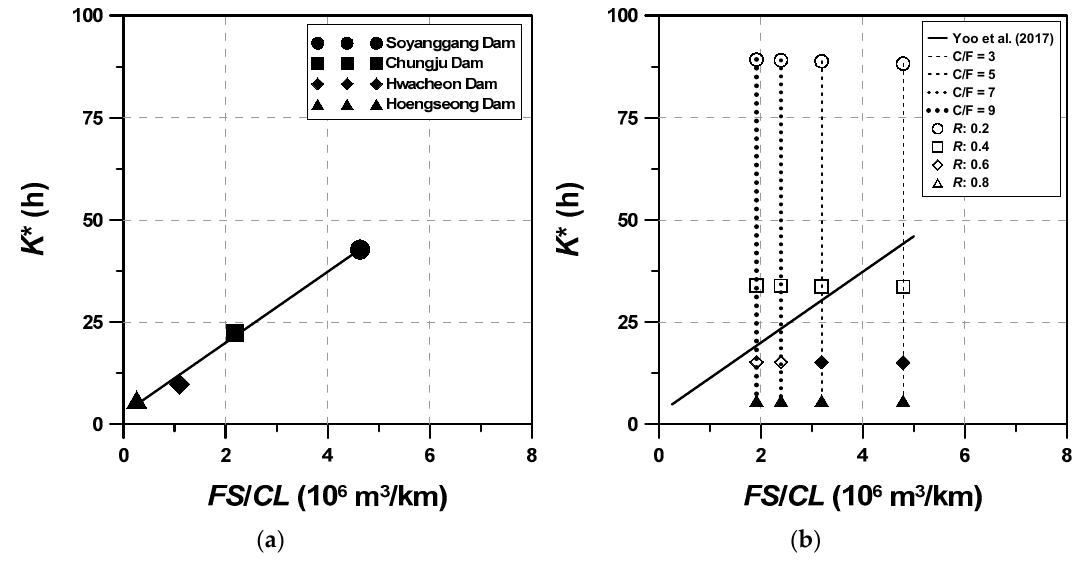
Figure 9. Empirical relation for estimating the dam storage coe ffi cient by [17] and its comparison to those cases considered in this study. ( a ) Yoo et al. [17]; ( b ) Cases in this study (the solid symbols represent the valid cases and the empty symbols non-valid ones based on the safety consideration of the Peace Dam).